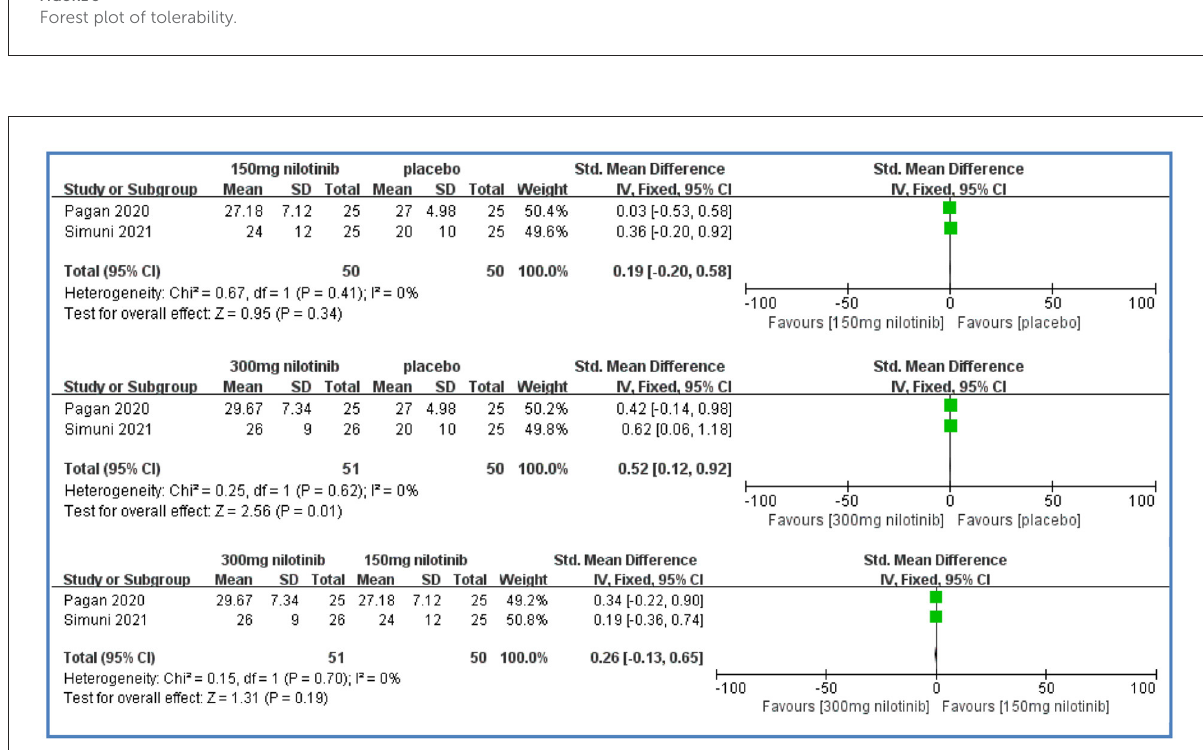
FIGURE4 Forest plot of MDS-UPDRS III